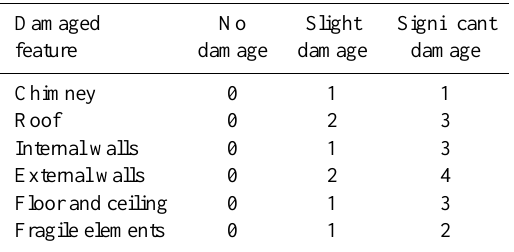
Table 1. Codes defined for the calculation of the damage index (Id) by the authors of the PSE-UL report to evaluate the damage of the buildings affected by the 1983